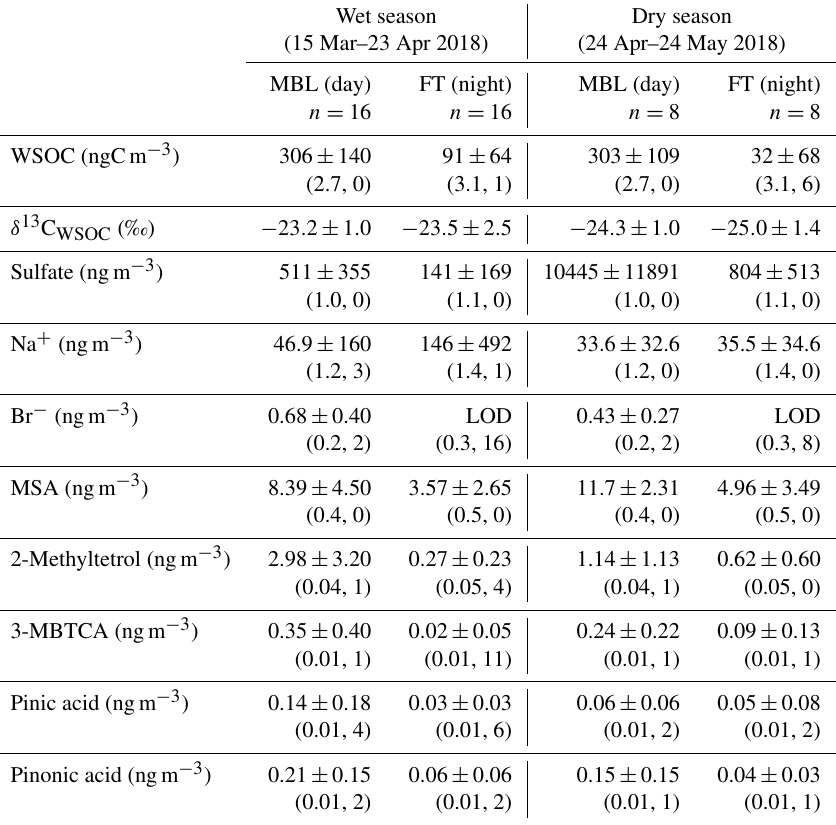
Table 1. Average concentrations and ratios of the major parameters under the marine boundary layer (MBL; daytime) and free tropospheric (FT; nighttime) conditions at the Maïdo observatory during wet and dry seasons. The numbers in the parentheses show the lower detection limit of mass concentration and the number of samples that showed values below the lower limit of detection (LOD) in each category. If the measured concentrations were below LOD, the concentrations were treated as zero when the averages and standard deviations were